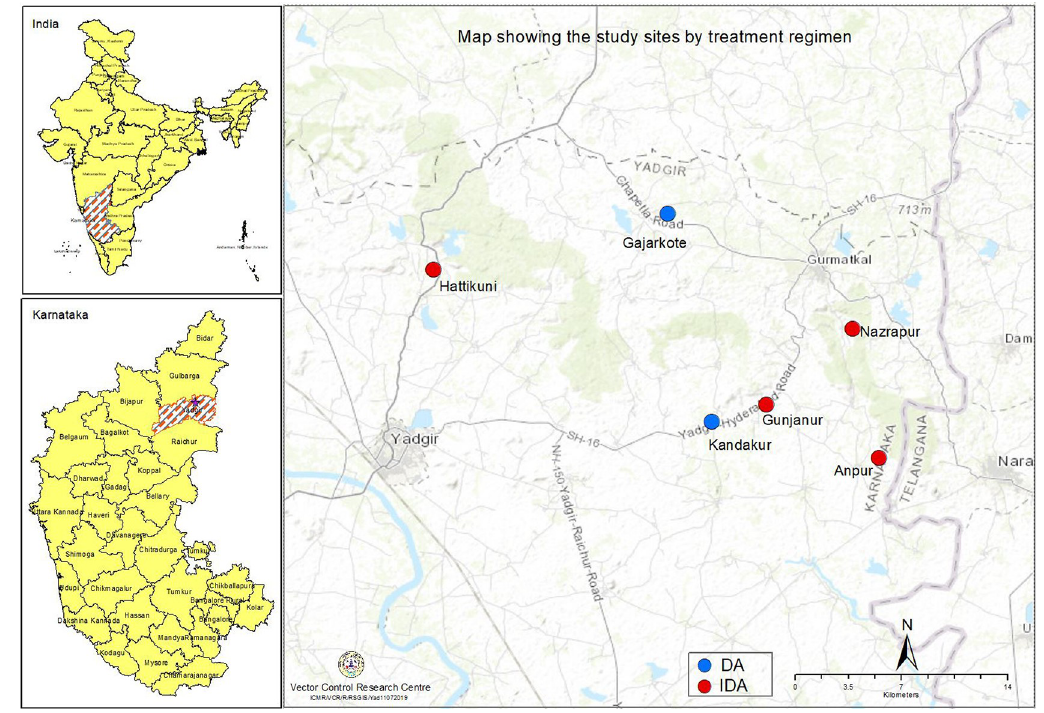
Fig 1. Map showing the study sites by treatment